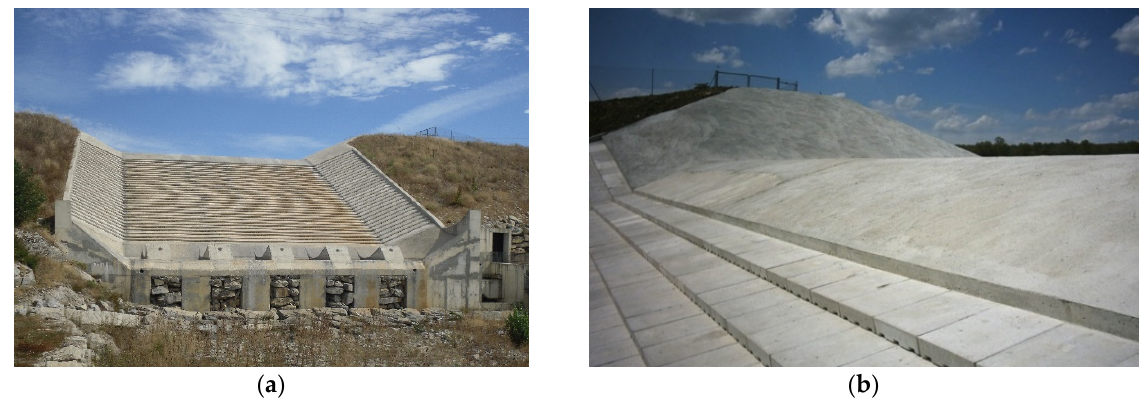
Figure 1. ( a ) The Barriga dam (Burgos, Spain). ( b ) The upper area detail of the WSB chute spillway of the Barriga dam.